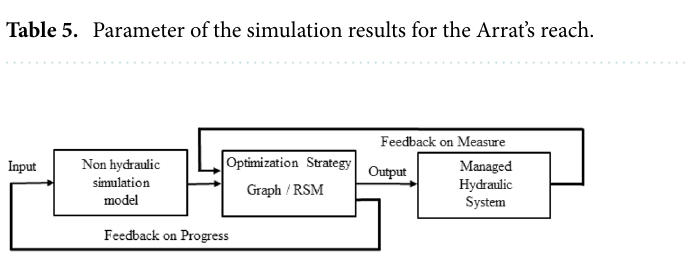
Figure 11. Scheme for the optimization strategy integrating hydraulic models.